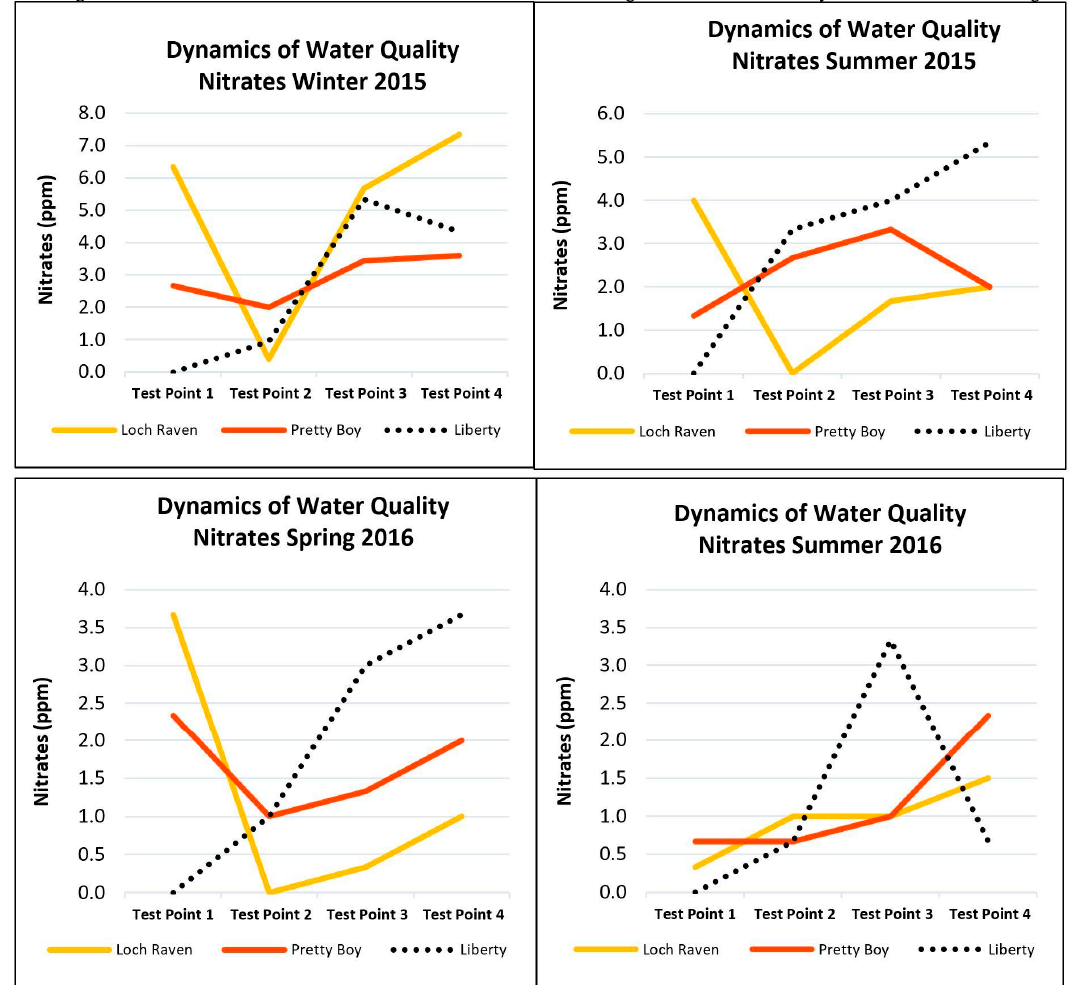
Figure 5. Dynamics of nitrate levels at Liberty, Loch Raven and Prettyboy watersheds during 2015–2016. Figure 5 charts the dynamics of nitrate concentrations seasonally over the two-year test